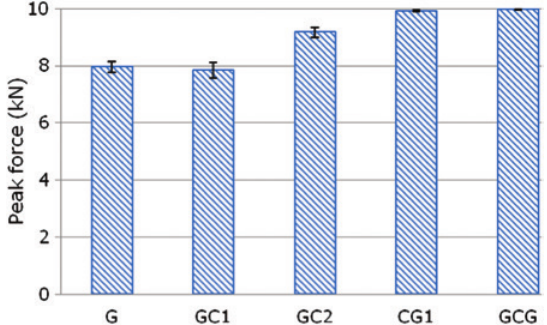
Figure 10: Maximum resistive force offered by the laminates.